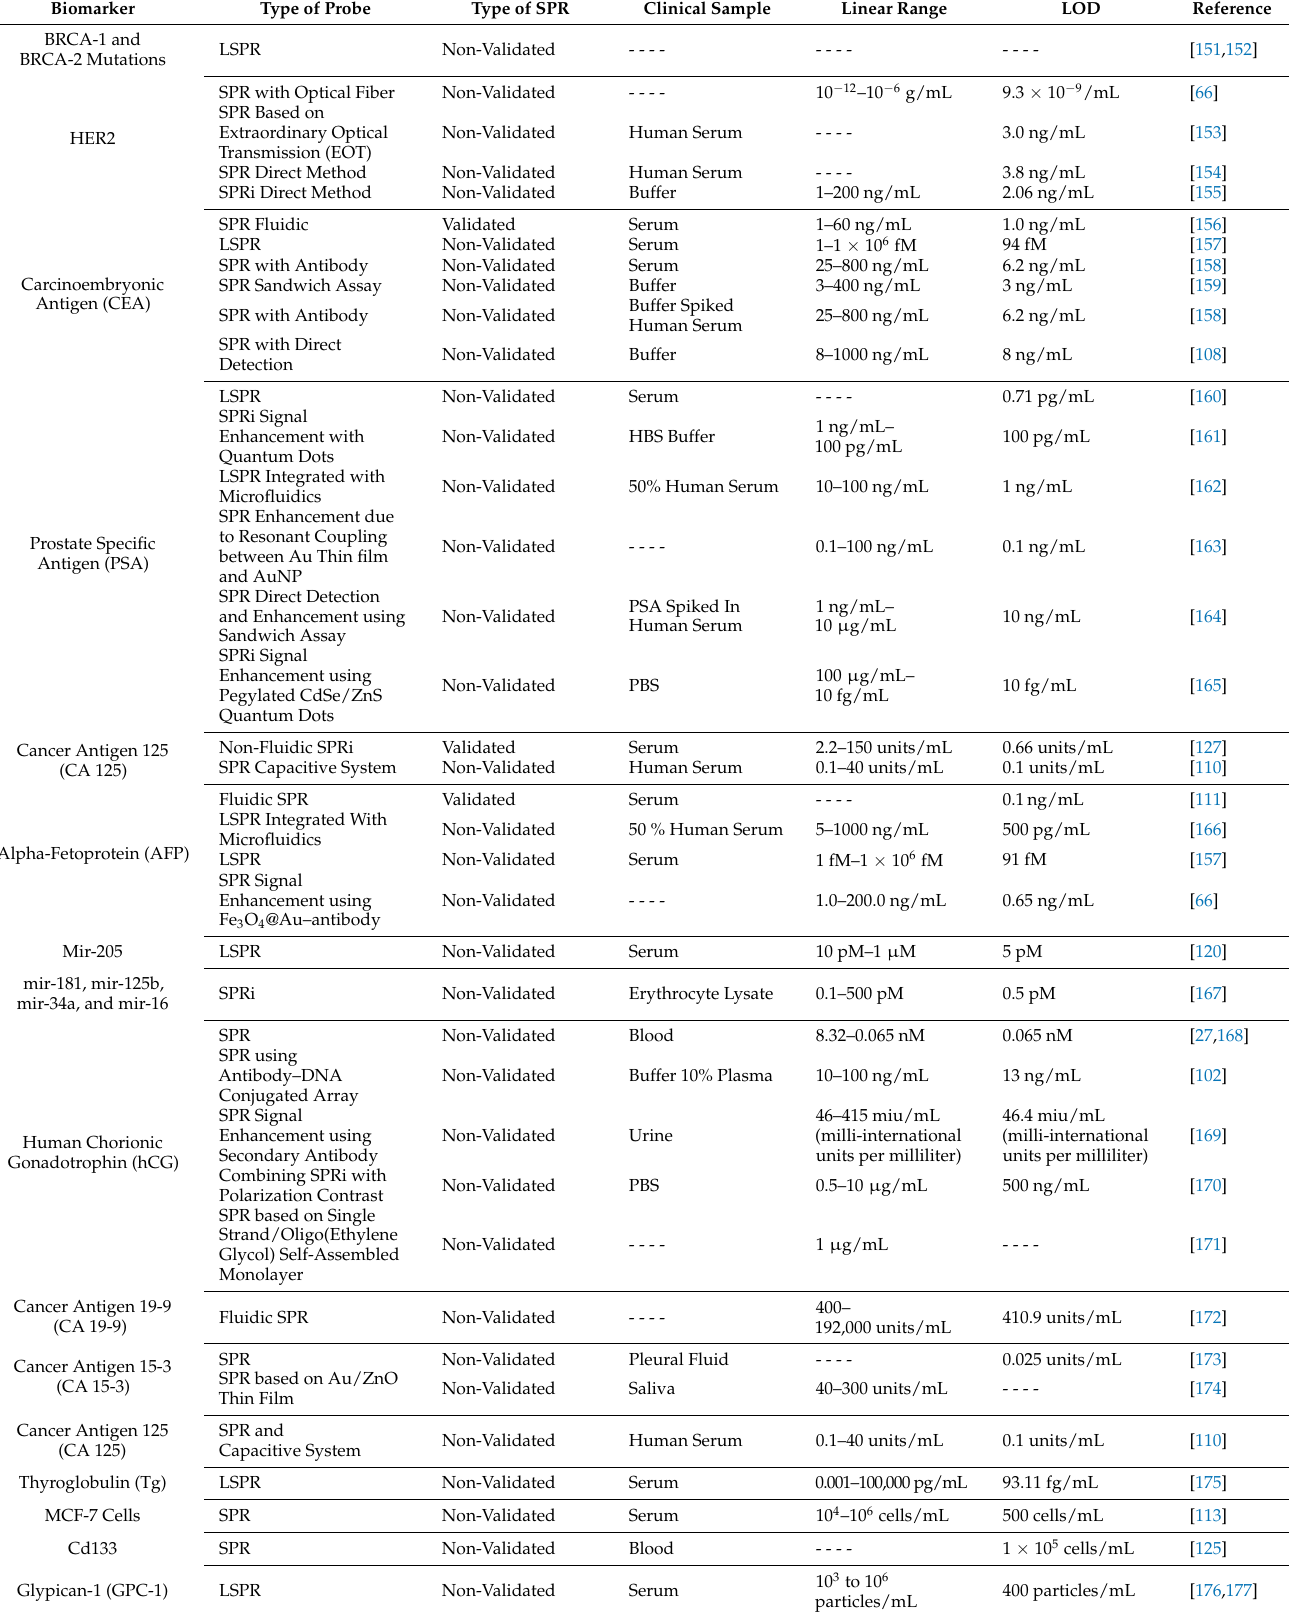
Table 2. Examples of potential SPR-based tools for detection of cancer